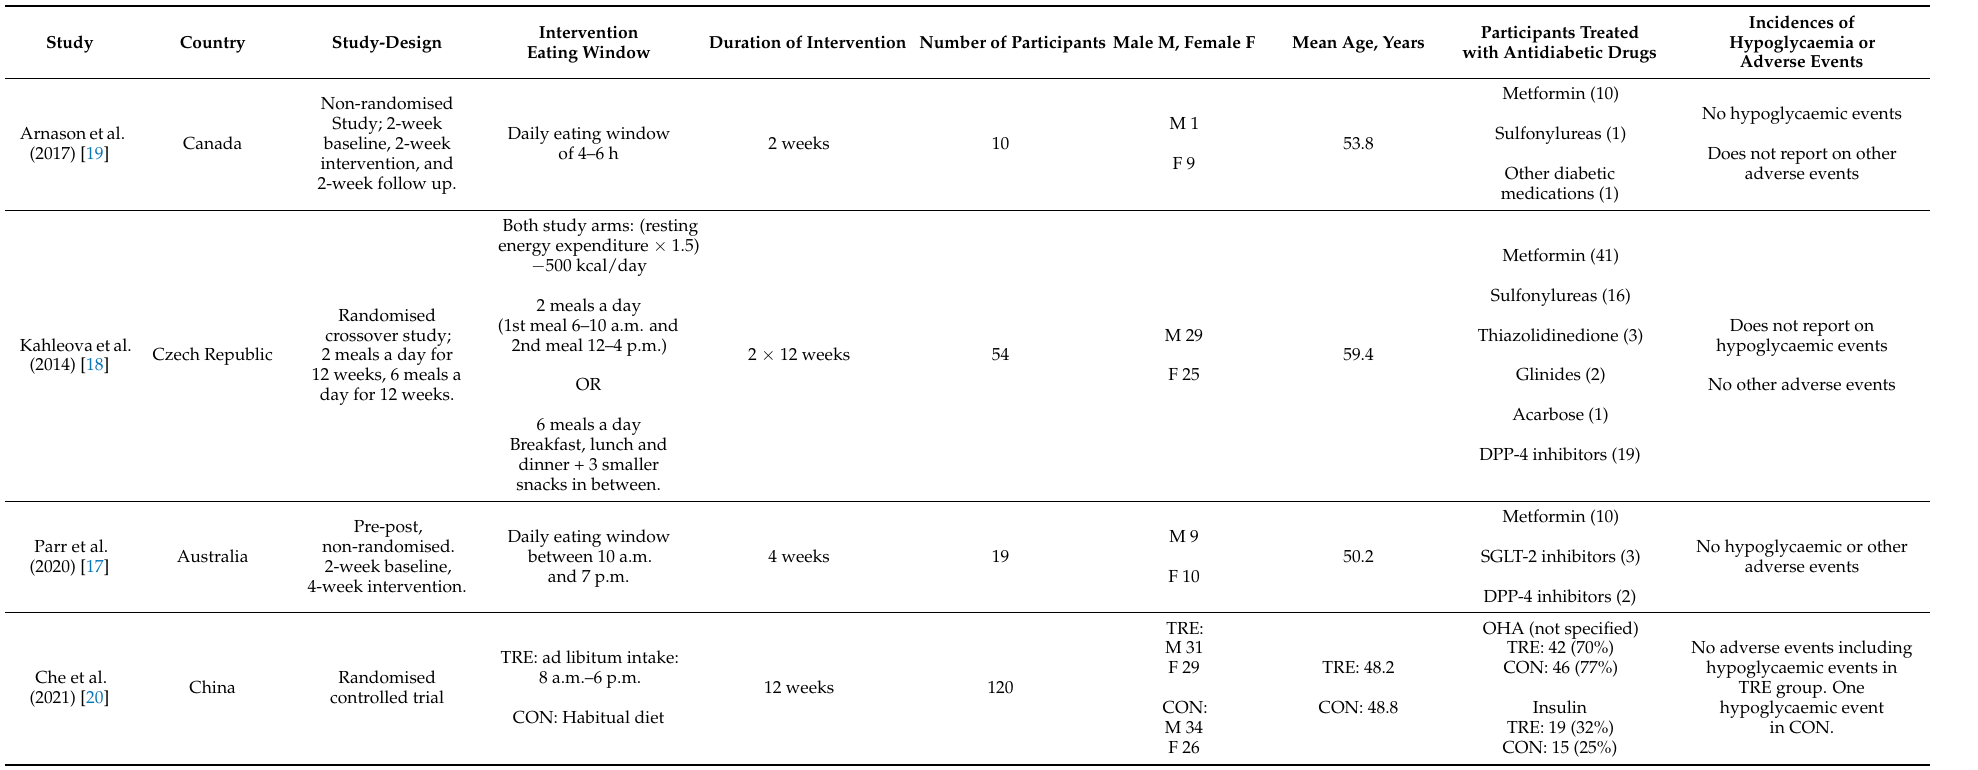
Table 1. Studies investigating time-restricted eating in people with type 2